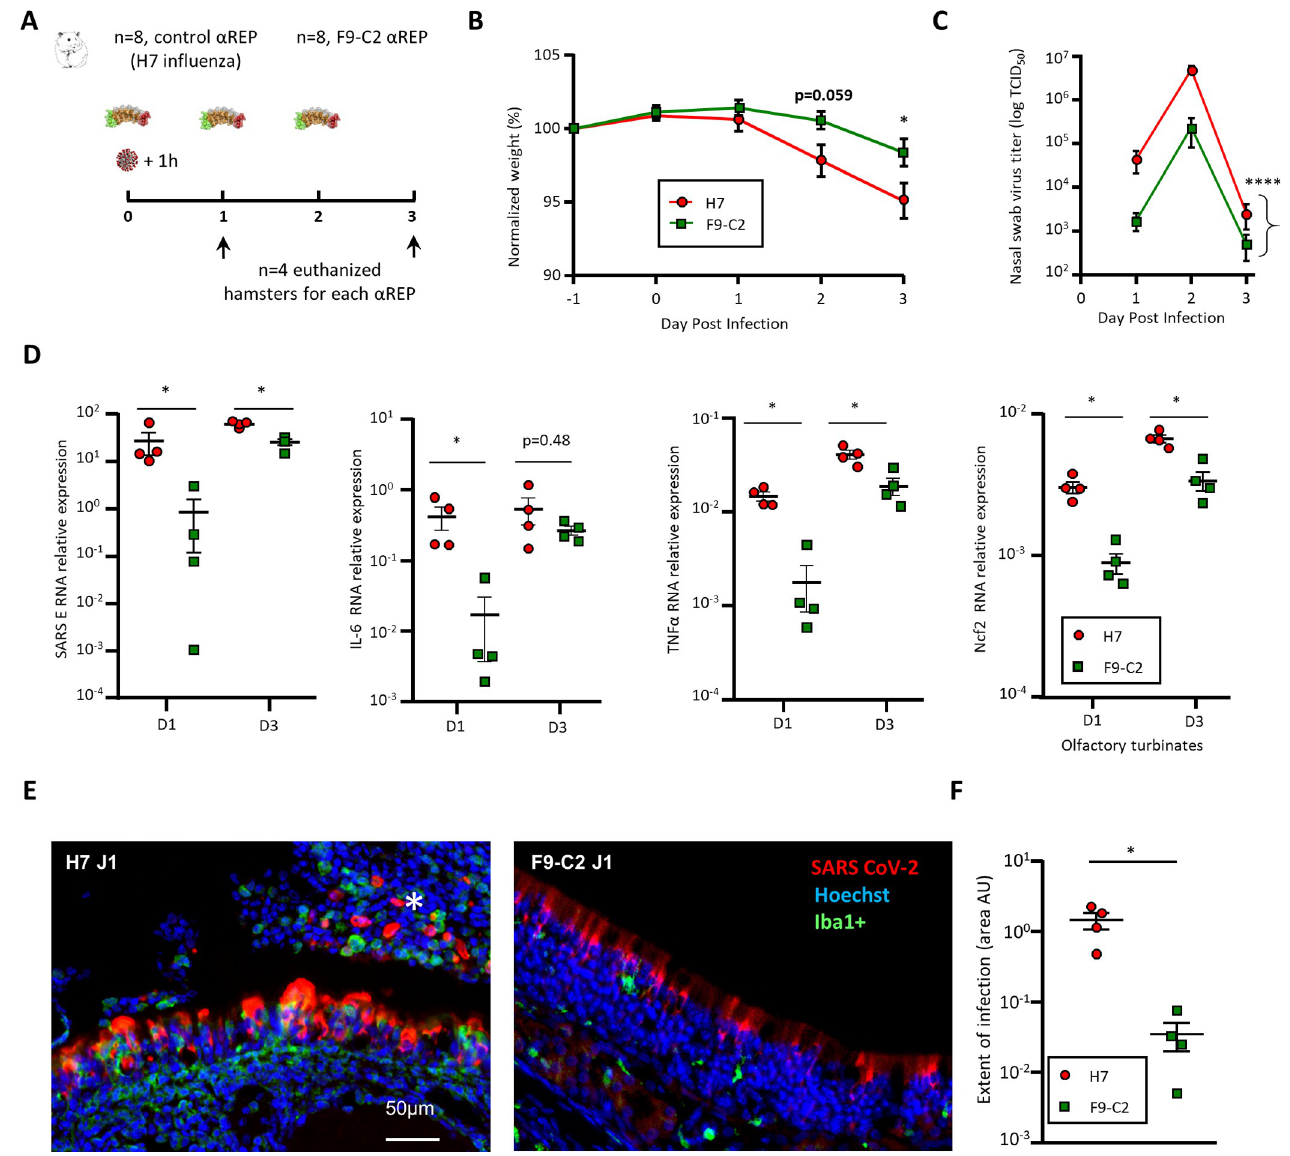
Fig 6. Efficacy of F9-C2 α Rep repeated treatments in SARS-CoV-2 infection in a golden Syrian hamster model. (A) Overview of the experiment design. 6 mg/kg of α Reps were delivered intranasally in hamsters 1h prior to infection with 5.10 3 TCID 50 of SARS-CoV-2. The treatment was repeated on 1 dpi and 2 dpi for the group examined at 3 dpi. ( B ) Evolution of animal weight (n = 4, mean of the relative weight to 1-day prior infection ± SEM, two-way ANOVA). ( C ) Evolution of virus titre in nasal swabs (n = 4, mean of TCID 50 ± SEM, two-way ANOVA, ���� P < 0.0001) ( D ) quantification of RNA encoding SARS-CoV-2 protein E, IL-6, TNF α , Ncf2 in the olfactory turbinates, relative to viral infection, inflammation and neutrophil respectively (normalized to ß-actin, mean ± SEM, Mann–Whitney � P < 0.05). (E) Representative images of the infected olfactory epithelium area treated by F9-C2 or H7 in the dorso-medial zone of the nasal cavity (1 dpi) showing respectively a partial infection with a low number of Iba1 + immune cell infiltration and a strong infection associated with damage of the olfactory epithelium and Iba1 + cell infiltration as well as desquamated cells in the lumen of the nasal cavity (white asterisk). (F) Measurement of the extent area of infection in the dorso-medial part of the hamster nose. Values represent the mean of infected area (Arbitrary Unit ± SEM, Mann–Whitney � P < 0.05). limited weight loss and the difference reach significance at 3 dpi when compared to controls (P = 0.015, 2-way ANOVA, Fig 6B ). During the 3 days post-infection, virus titres in nasal swabs were lower in the group treated with F9-C2 than in the control group ( Fig 6C, two-way ANOVA, P < 0.0001). Viral RNA was significantly lower in olfactory turbinates at 1 dpi and 3